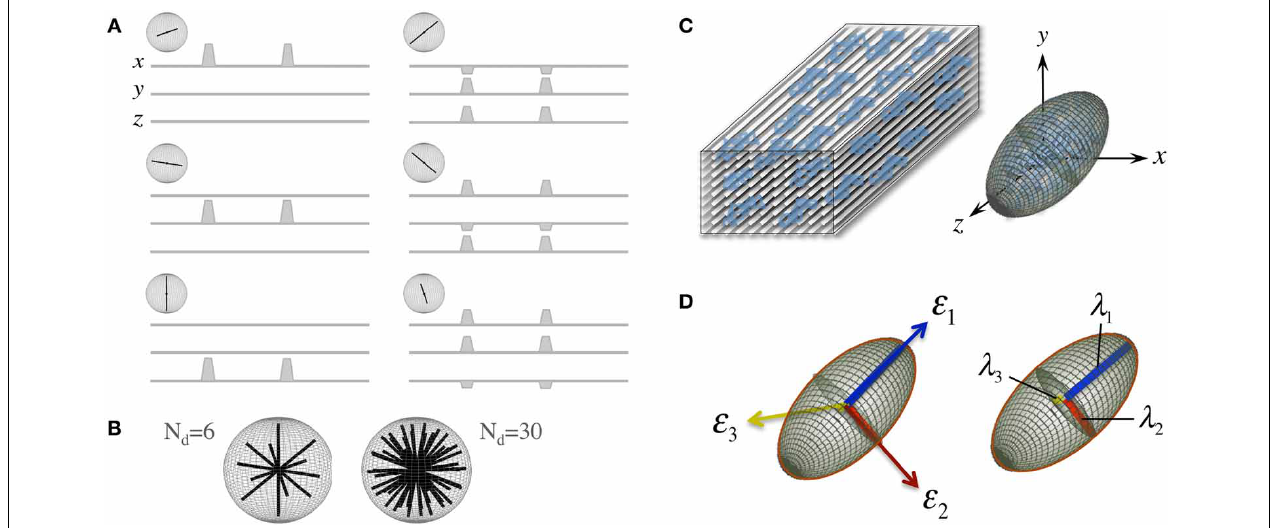
FIGURE 2 | The “diffusion tensor.” (A) Six combinations of gradients applied with different intensities along three orthogonal orientations ( x , y , and z ), and a measurement without diffusion weighting, are the minimum requirements to probe diffusion in a 3D space; each non-collinear combination is called a “diffusion direction.” (B) A larger number of diffusion directions, N d , can estimate the directional dependence of microstructural restrictions to water diffusion with greater precision. (C) Basser et al. (1994b) proposed the formulation of a diffusion tensor (represented by an ellipsoid) to capture diffusion behaviors in 3D with a